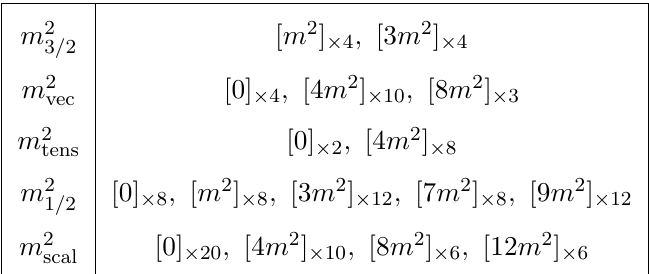
Table 18 . Masses for the Minkowski vacuum